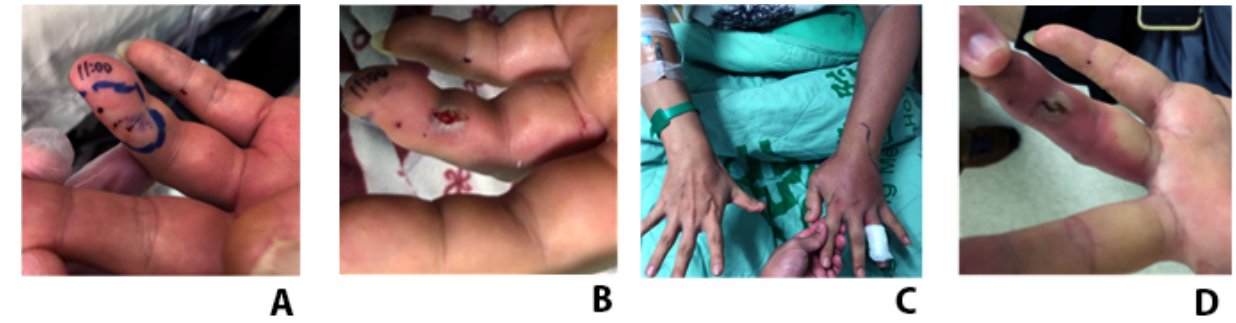
Figure 3. The evolution of wounds in an early debridement case. (A) This 40-year-old man presented to our emergency department due to snakebite on the left 4 th finger one hour before. (B) Wound incision and debridement at ED two hours after the snakebite. (C) Swelling on the left forearm on day 2. (D) Good wound condition on the 4 th day after the